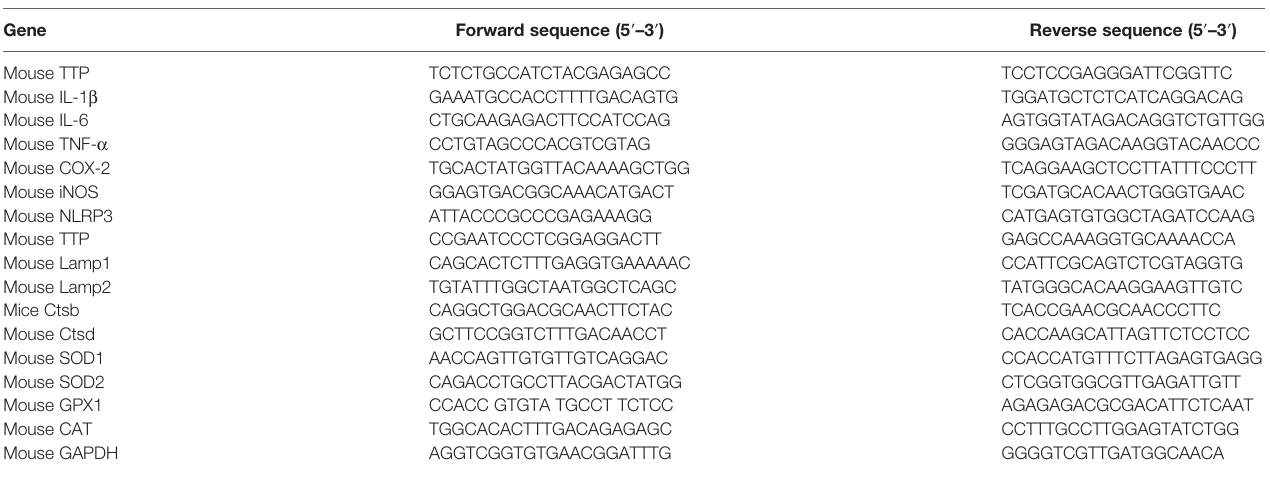
TABLE 1 | The primers used for quantitative